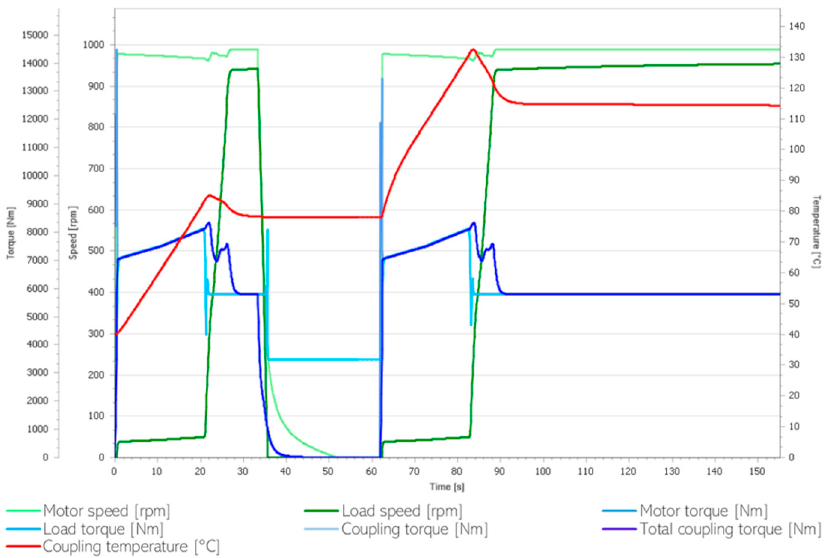
Figure 10. Dynamic simulation of two ball mill start-up processes with the use of the TVV 866 fluid coupling.